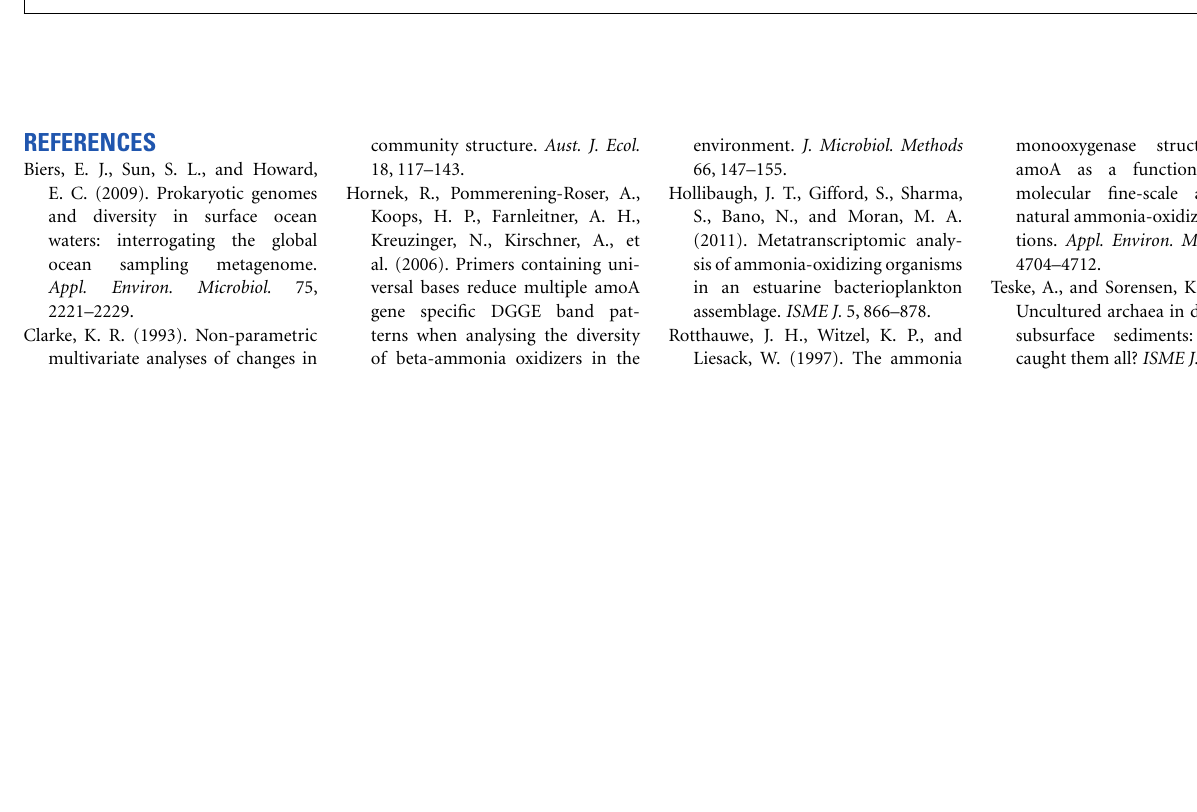
complementary to theWuchter et al. (2006) and Francis et al. (2005) primer sets.The top line represents the consensus sequence, while arrows indicate key differences between environmental and primer